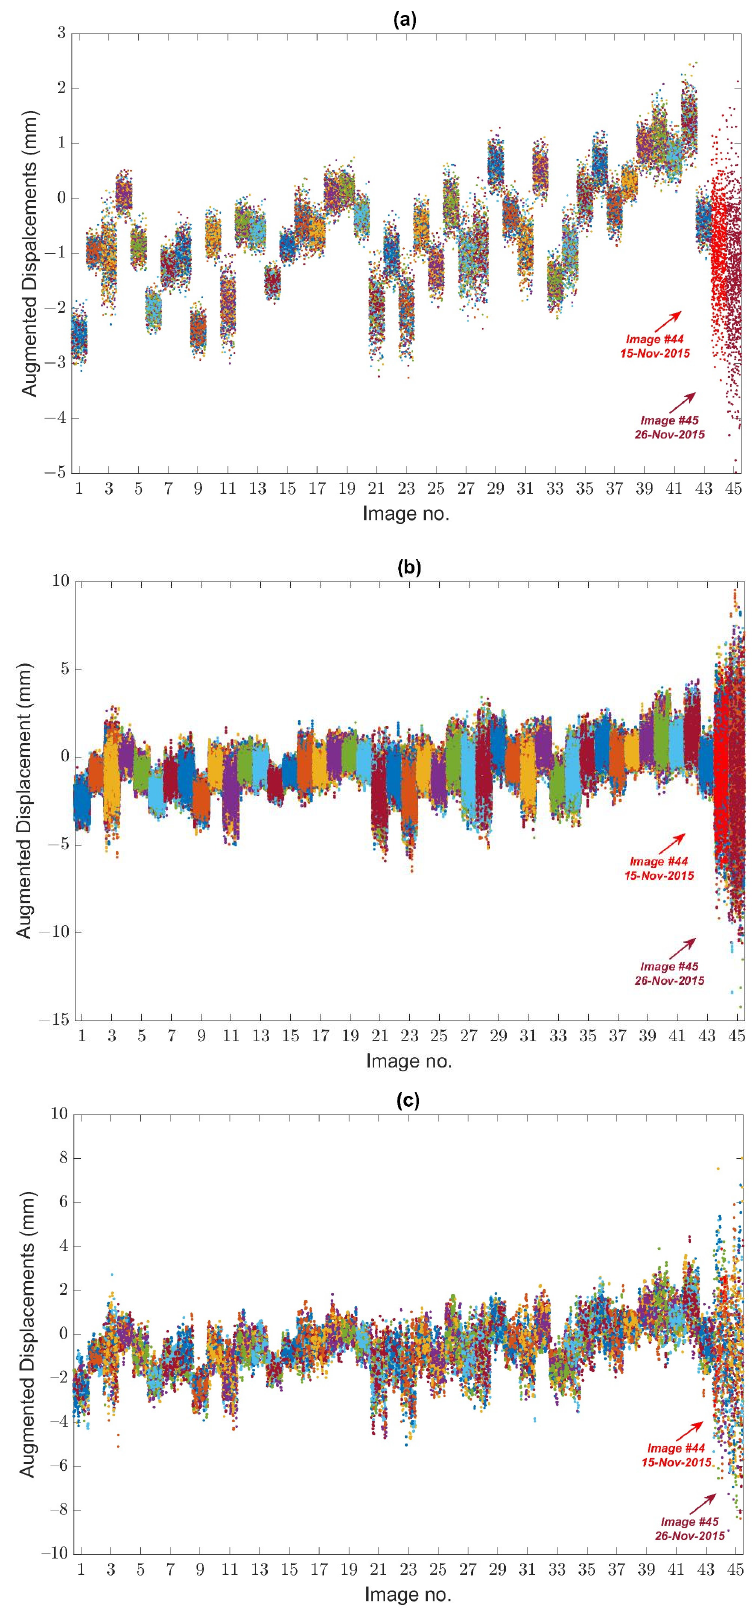
Figure 7. Augmented displacement samples: ( a ) the HMC sampling N = 100, ( b ) the slice sampling N = 1000, ( c ) the slice sampling N = 100.